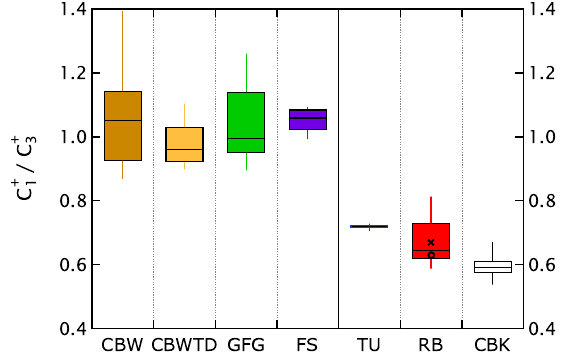
/ C + Fig. 4. SP-AMS C + ratios for CAST “Brown” particles 1 3 (CBW), thermodenuded CBW (CBWTD), spark-generated parti- cles (GFG), fullerene-enriched soot (FS), aircraft-turbine particles (TU), Regal Black (RB), and CAST “Black” particles (CBK). All samples were monodisperse particles at multiple sizes, except TU. Fig. 5. Scatterplot of mass spectral intensities at each C + x up to Each box spans the 25th to 75th percentile. Vertical lines extend to x = 16. All spectra are normalized to unity and plotted against the the 10th and 90th percentiles. The horizontal line within each box FS C + x spectrum. The white numbers labeling RB (red squares) in- / C + shows the median. The mean C + ratio for RB is shown for the 1 3 dicate the number of carbon atoms x in each C + x for both RB and present study ( × ) and for independent measurements by Onasch FS. For clarity, some labels have been omitted, namely C + x with et al. ( ◦ ). x = 6 (next to 8), 12 (next to 14), and 10 (next to 15). Error bars indicate ion counting uncertainties, and are not shown when they are smaller than the data